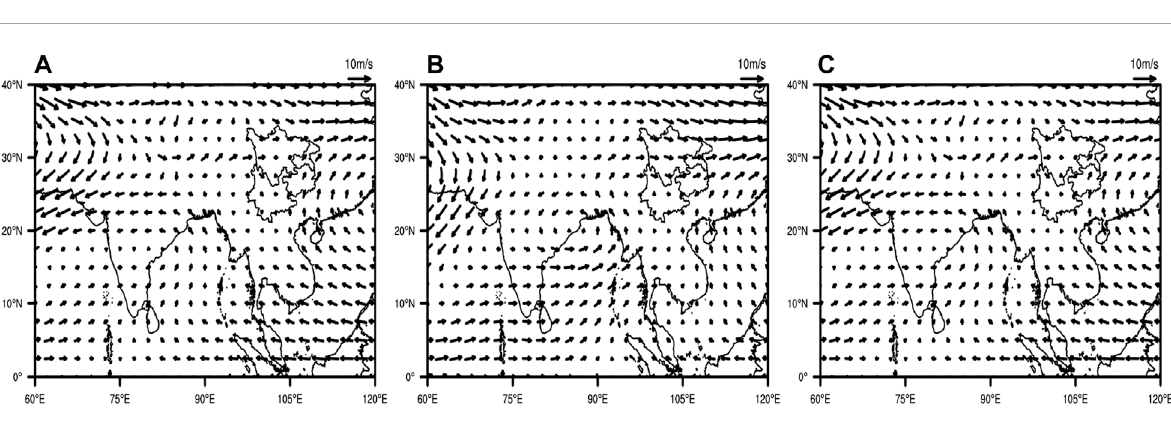
Frontiers in Earth